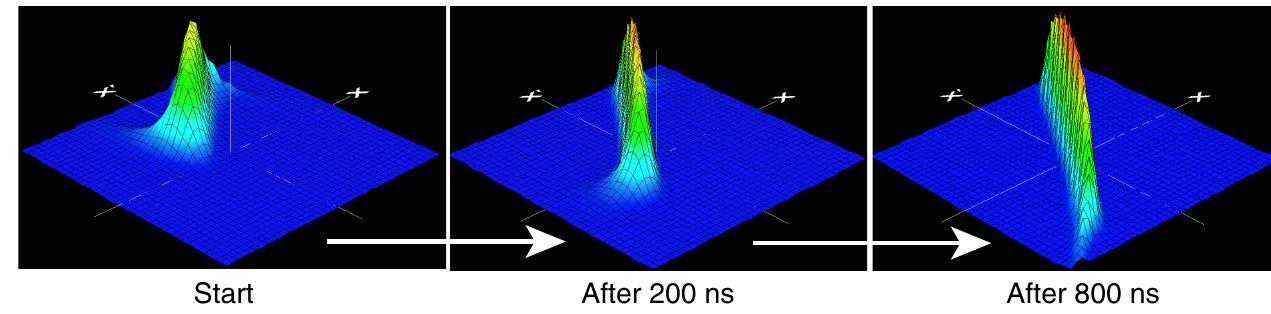
FIG. 9. (Color) Time evolution of the phase-space profile.